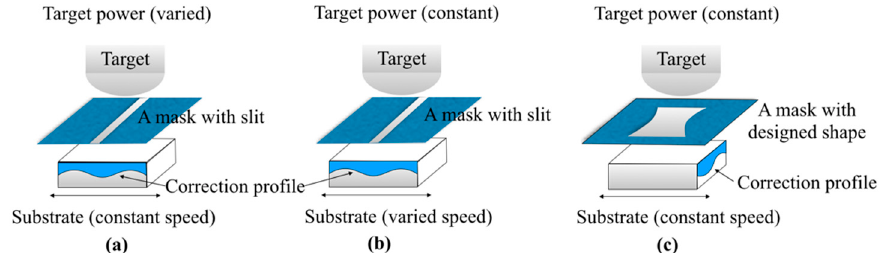
Figure 1. Di ff erent processes of coating methods. ( a ) Di ff erential deposition (varied target power). Figure 1. Different processes of coating methods. ( a ) Differential deposition (varied target power). ( b ) ( b ) Di ff erential deposition (varied substrate speed). ( c ) Profile Differential deposition (varied substrate speed). ( c ) Profile coating.